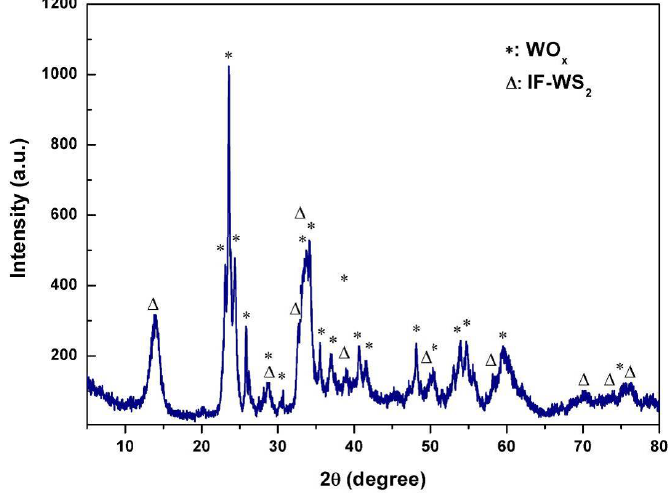
from experiment S1 (reaction of WO 2